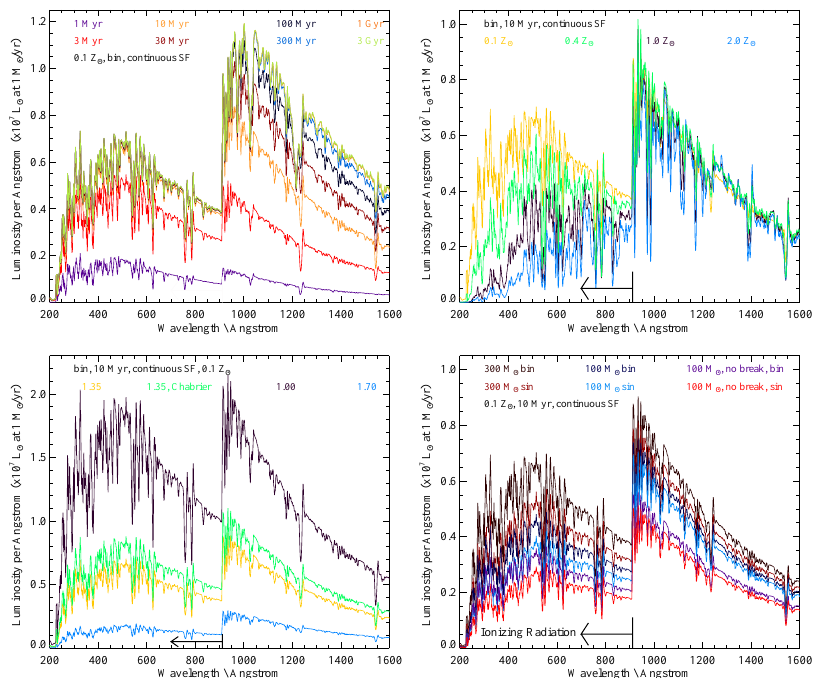
Figure 2. The impact of the assumed initial mass function (IMF), age, metallicity and binary fraction on the far-ultraviolet (ionising) emission from a stellar population produced by BPASS v2.2 [59]. Top Left : the effect of age for a population incorporating binary models at Z = 0.1Z (cid:12) , which has been forming stars continuously at the rate of 1M (cid:12) per year for different lengths of star bursts. The assumed initial mass function is a broken power law with a slope of − 1.35 between 0.5 and 300M (cid:12) and − 0.3 between 0.1 and 0.5M (cid:12) . Top right: the effect on a 10 million year old binary population with the same IMF of altering the stellar metallicity. Bottom left: the effect on a 10 million year old binary population at Z = 0.1Z (cid:12) of altering the upper slope of the IMF, or replacing the low mass break with an exponential (Chabrier [60]) cut-off. Bottom right : The effect on the same population of altering the upper mass cut-off and of removing the lower break (i.e., a constant IMF slope of − 1.35 between 0.1 and 100M (cid:12) ) on populations incorporating only single or single and binary stellar evolution